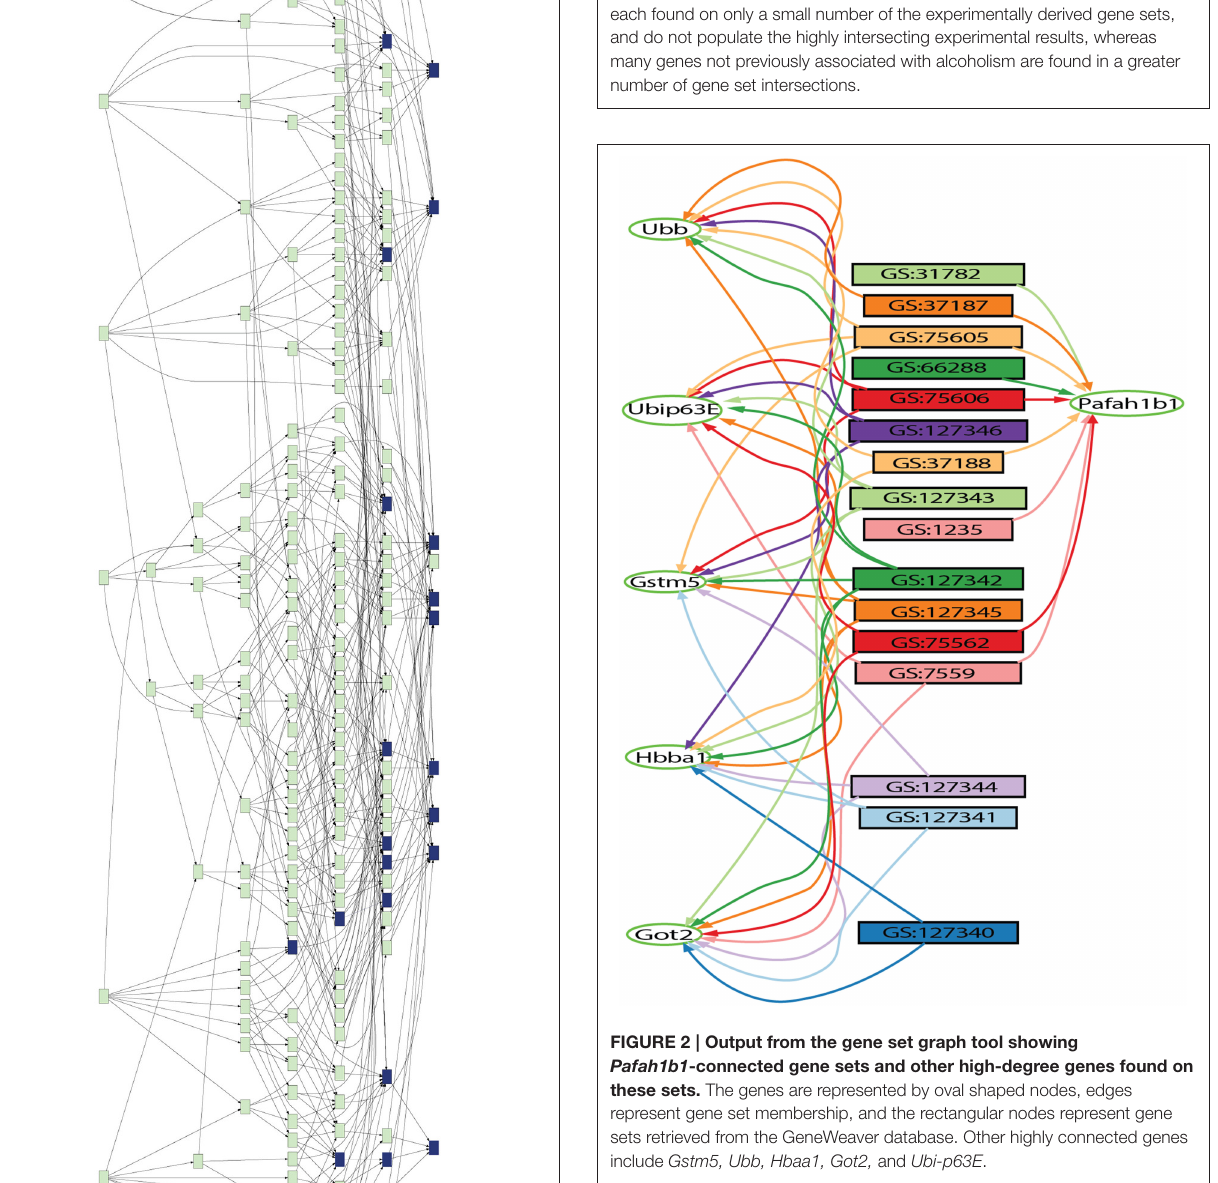
using MANOVA to estimate the effects of genotype, sex and their U represents the symmetric nature of the variance interaction. ˜ co-variance matrix of the random effects. In order to determine the nature of differences detected in the ANOVA model, planned contrasts were performed giving the terms not included in the model a weight of zero and giving the terms to be compared (sex and genotype) values of opposite weights, − 1 and +